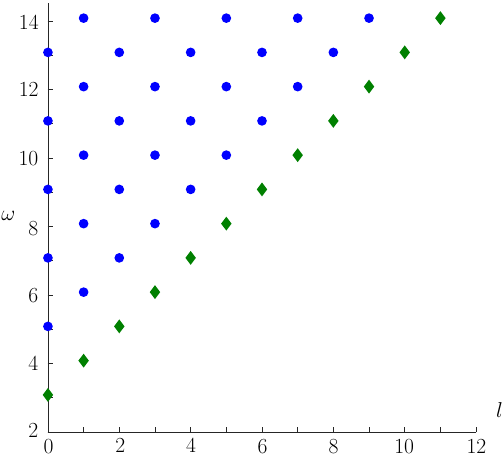
Figure 1 . The frequencies of the linearized normal modes (2.21) for different values of n and l . Each dot represents a full multiplet of states with angular momentum l containing ( l + d − 3)!(2 l + d − 2) / ( l !( d − 2)!) states with degenerate frequencies given by (2.24) and evaluated at d = 3 and m = 1 / 2 . The multiplets containing the maximally rotating modes, to play a crucial role in our later considerations, are highlighted and displayed as green